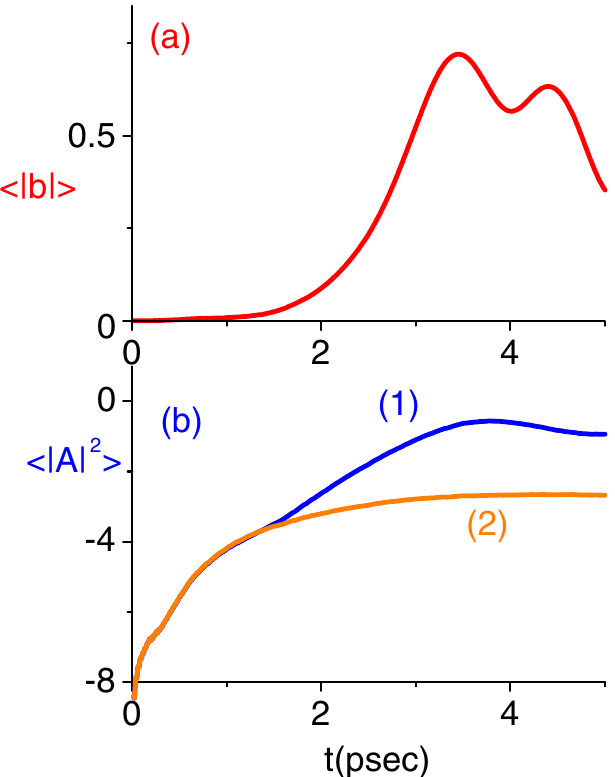
FIG. 5. (Color) Averaged bunching [window (a)] and logarithm of the radiation intensity [window (b)] versus time in the coherent (1) and incoherent (2) case for: (cid:1) 0 : 8 , (cid:4) (cid:6)=(cid:6) (cid:4) 10 (cid:1) 4 , (cid:4) !=! (cid:4) (cid:1) 2 (cid:11) 10 (cid:1) 4 , "